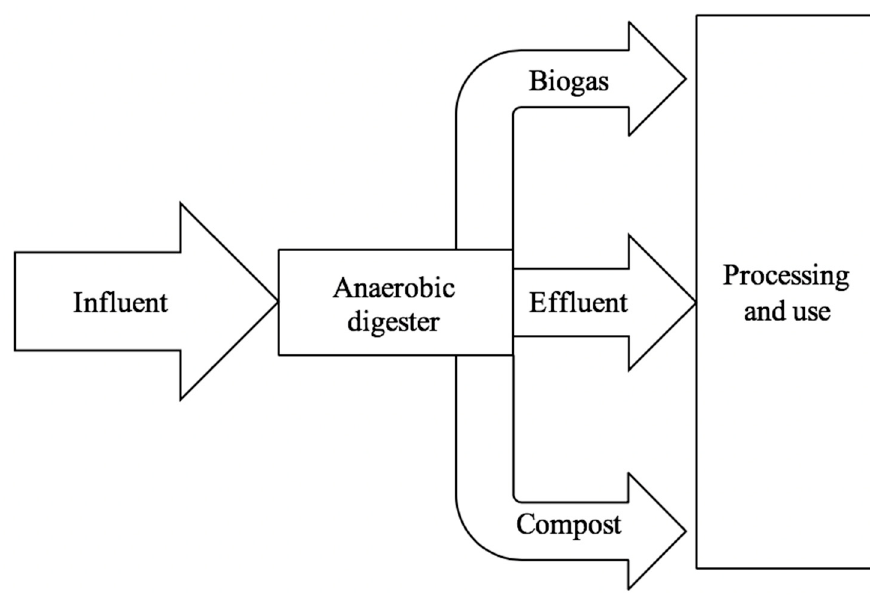
Figure 2. The anaerobic digestion influent and output streams.